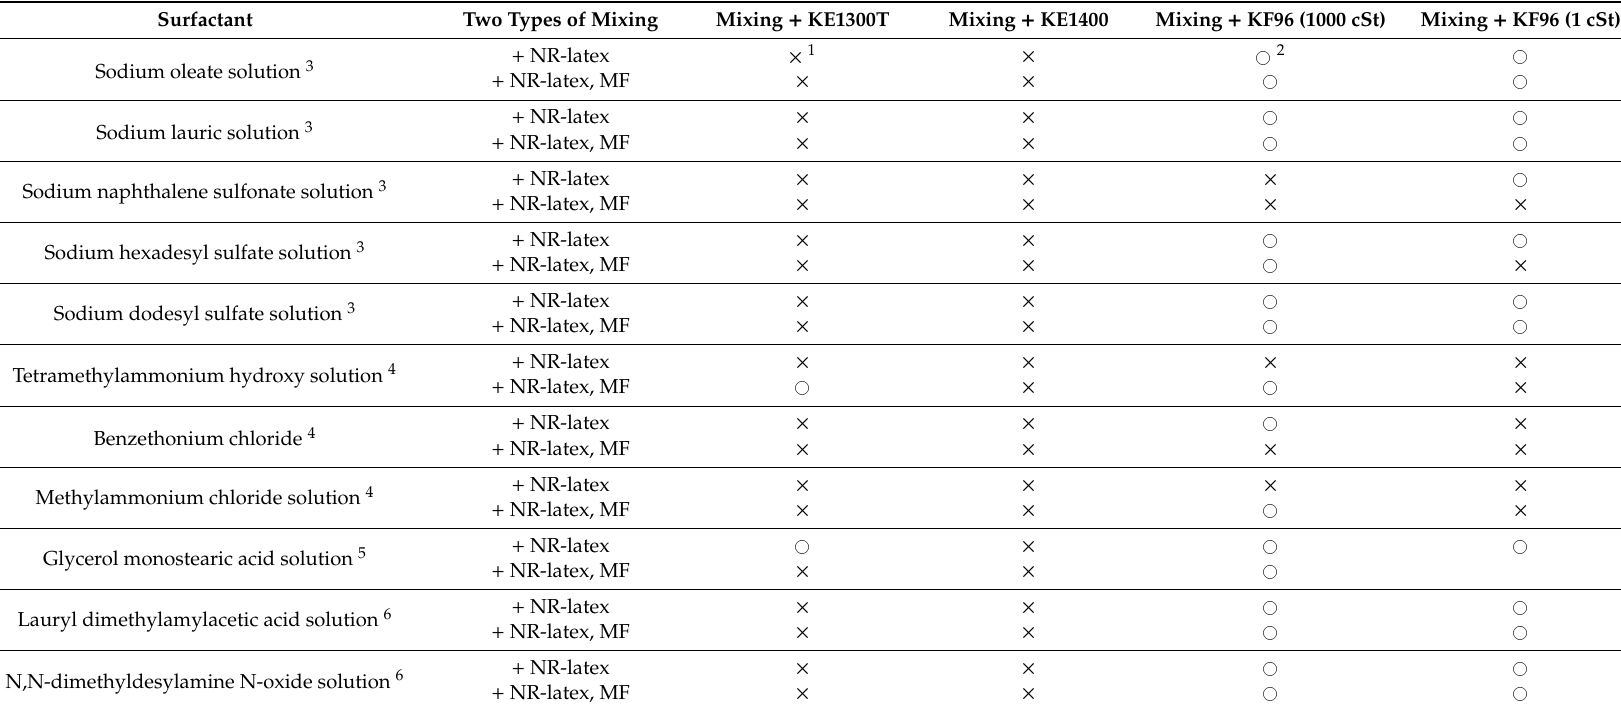
Table 1. Results of the possibility of mixing and electrolytic polymerization with surfactant and Q rubber liquid. Surfactant Two Types of